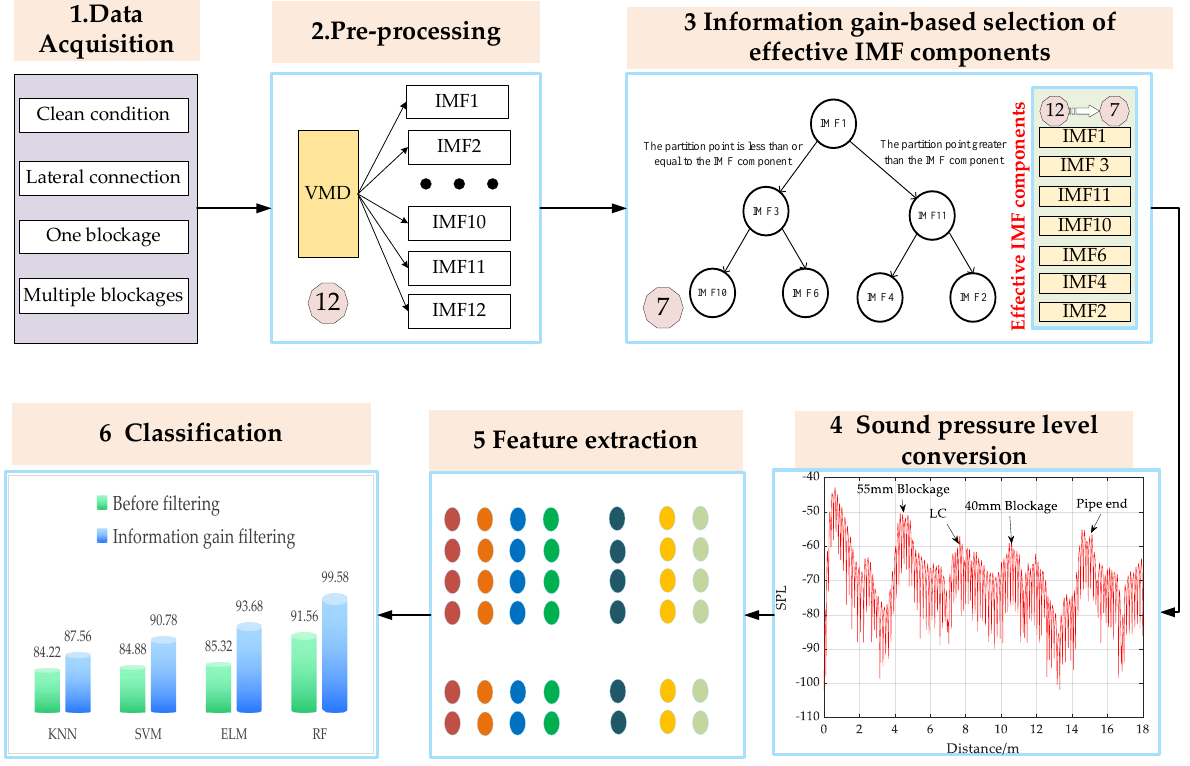
Figure 1. The flow diagram of the proposed method.